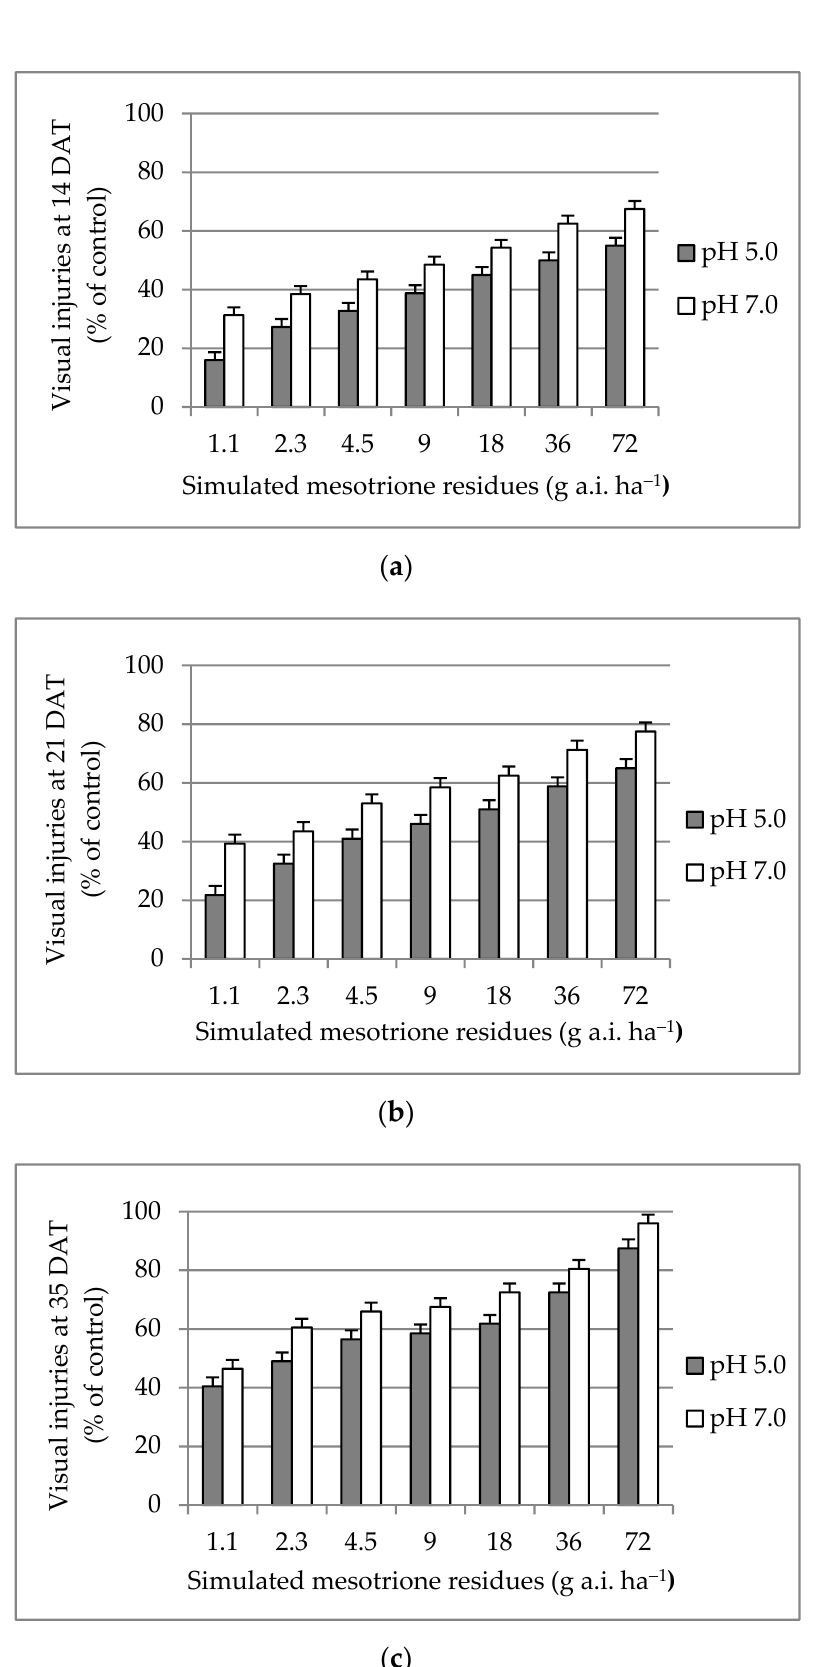
Figure 1. Visual injury (% of control) evaluation of pea at 14 ( a ), 21 ( b ) and 35 ( c ) days after treatment with simulated mesotrione residues applied to soil at pH 7.0 and pH 5.0. Vertical lines indicate a statistical difference according to Fisher’s LSD test at p ≤ 0.05.